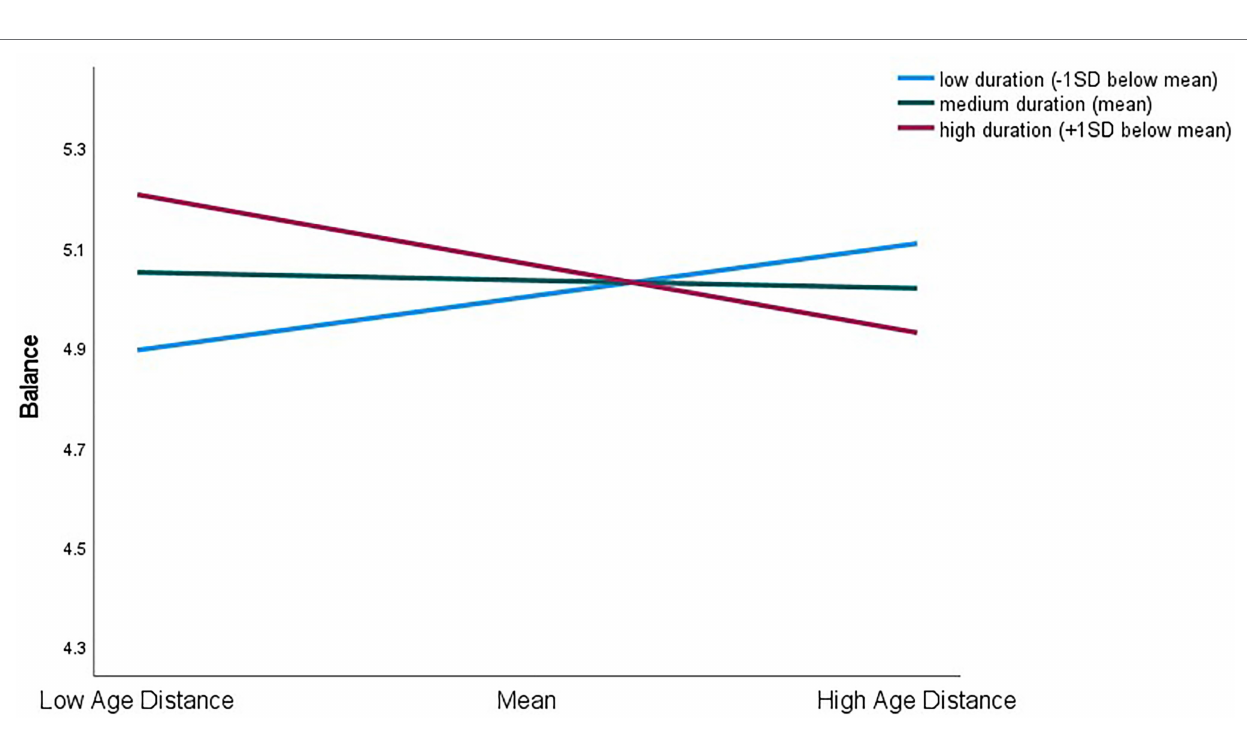
FIGURE 2 | Interaction effects between Age Distance and duration of supervisory relationship for prediction of supervisory ratings of